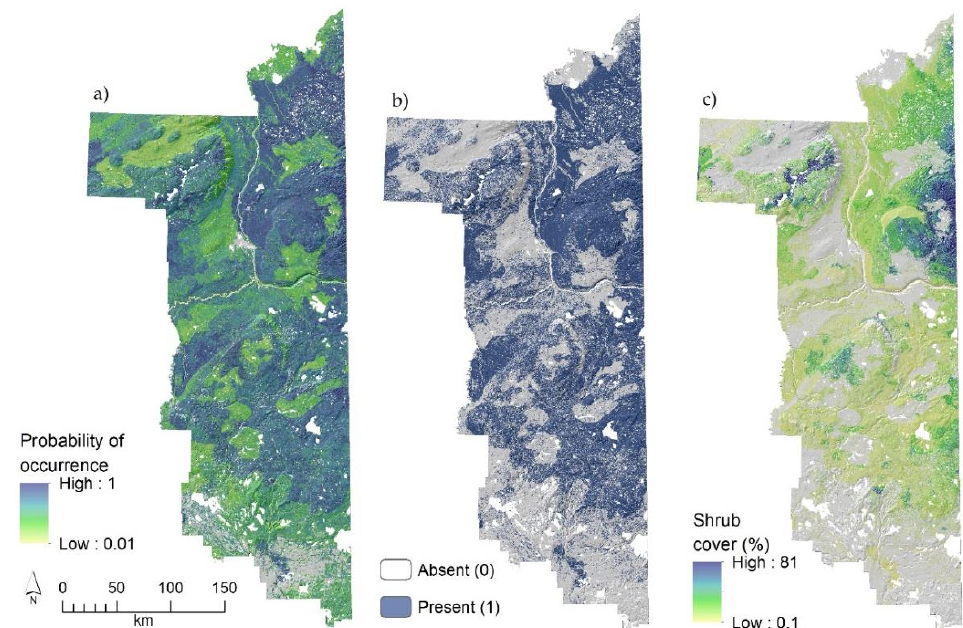
Figure 3. Predicted probability of occurrence ( a ), presence ( b ), and abundance ( c ) of velvet-leaf blueberry ( Vaccinium myrtilloides Michaux) in northeast Alberta, Canada. White areas represent lakes, and grey areas lack native vegetation (agriculture, etc.) in ( a ) or areas predicted to have no blueberry shrubs ( b , c ). A digital elevation model-derived hillshade model is used as a base layer in maps to emphasize the underlying terrain.